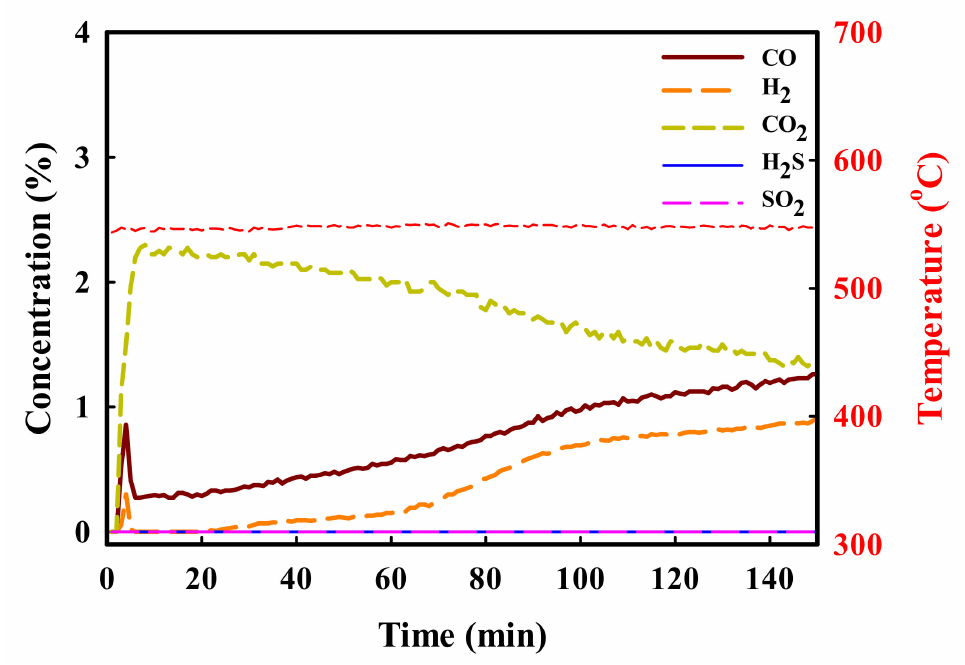
Figure 6. Variation in gas composition in the desulfurization process using 3600 ppm H 2 S containing reducing gas (6.5% CO, 2.95% H 2 , 0.15% CO 2 balanced by N 2